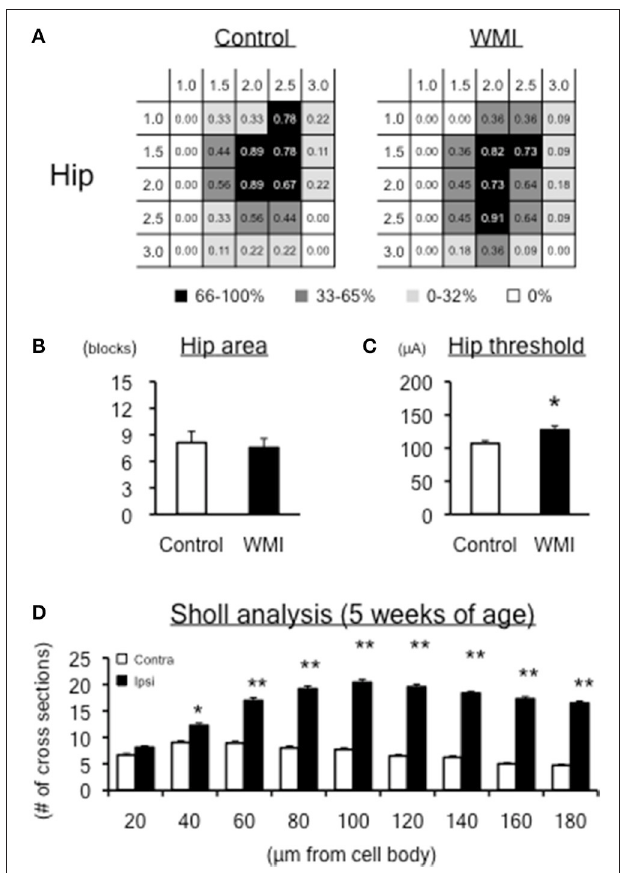
FIGURE 4 | Motor map and dendrite expansion at 5 weeks of age. (A) A summary of the motor maps in Supplemental Figure 1 is shown as a heat map. Although map size at 5 weeks of age appears to be smaller than that at 10 weeks of age, the size of the hip area of the WMI group ( n = 11) was unchanged compared with control animals ( n = 9). (B) The number of blocks in the hip area was unaltered between groups. (C) The threshold for eliciting hip joint twitch was significantly higher in the WMI group. (D) Twenty-seven Golgi-positive neurons per animal were assessed by Sholl analysis in both ipsilateral and contralateral sensorimotor cortex of neonatal WMI model ( n = 4) at 5 weeks of age. Sholl analysis revealed that the number of cross sections increased over 60 µ m from cell bodies on the right side of the cortex, even at 5 weeks of age. * p < 0.05 and ** p < 0.01 by Mann–Whitney U -tests. Data are presented as mean ±